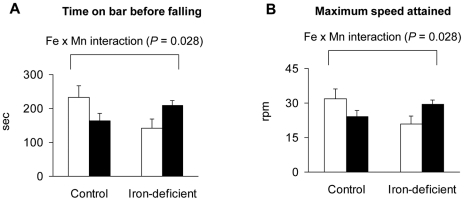
Effect of iron deficiency and manganese exposure on motor coordination of the rat.Rats were pair-fed, intranasally instilled (6×10 mg/kg) for 3 wks, and tested on the rotarod device to record the time to falling-off (A) and speed of the rod (B). Empty and closed bars represent water-instilled and MnCl2-instilled rats, respectively. Data were presented as mean ± SEM (N = 3–4 per group) and were analyzed using two-way ANOVA.